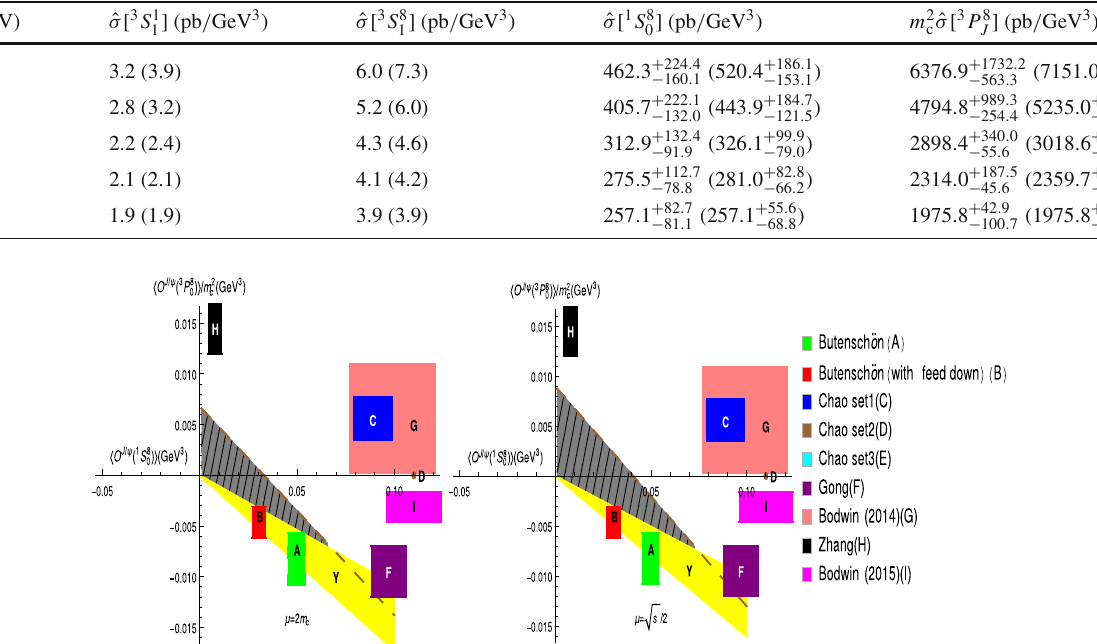
Fig. 1 The constraints of LDMEs are given using the experimental data of J /ψ inclusive production at the B-factory [29] and J /ψπ + π − production in the energy region of 4 . 6 − 5 . 6 GeV [23,24]. The former givesanupperboundcorrespondingtothe browndashedline .Thelatter gives a lower bound corresponding to the yellow band labeled Y . The